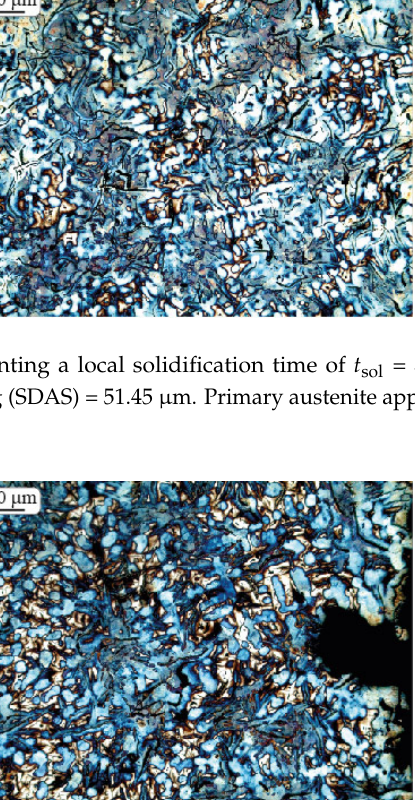
hyd D = 26.2 μ m and SDAS IP